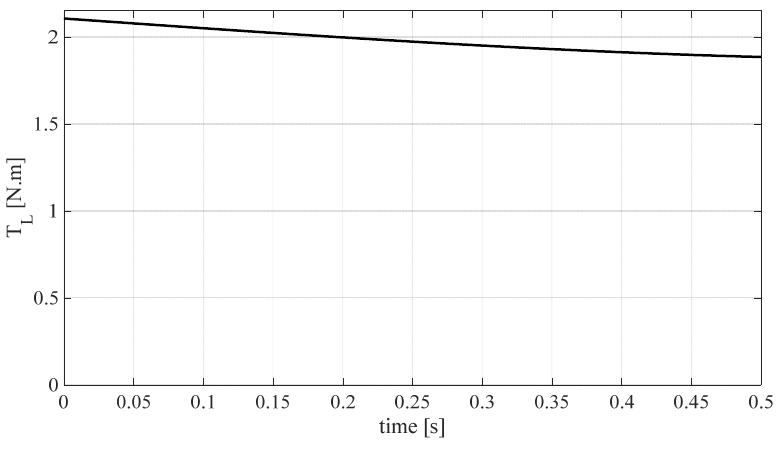
Figure 9. Load torque applied to the PMSM.